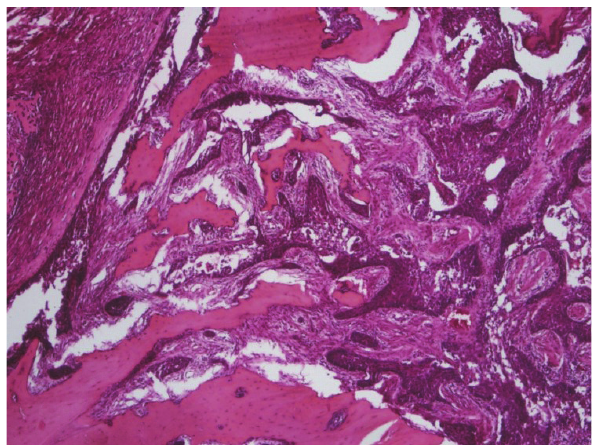
Fig. 3. Erosive form of bone invasion by oral squamous cell carcinoma (Hematoxylin and Eosin staining,